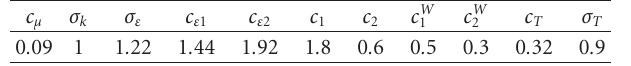
Table 2: Turbulence modelling